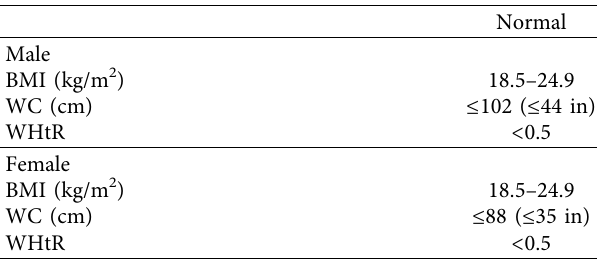
Table 2: Normal range of anthropometric indexes.